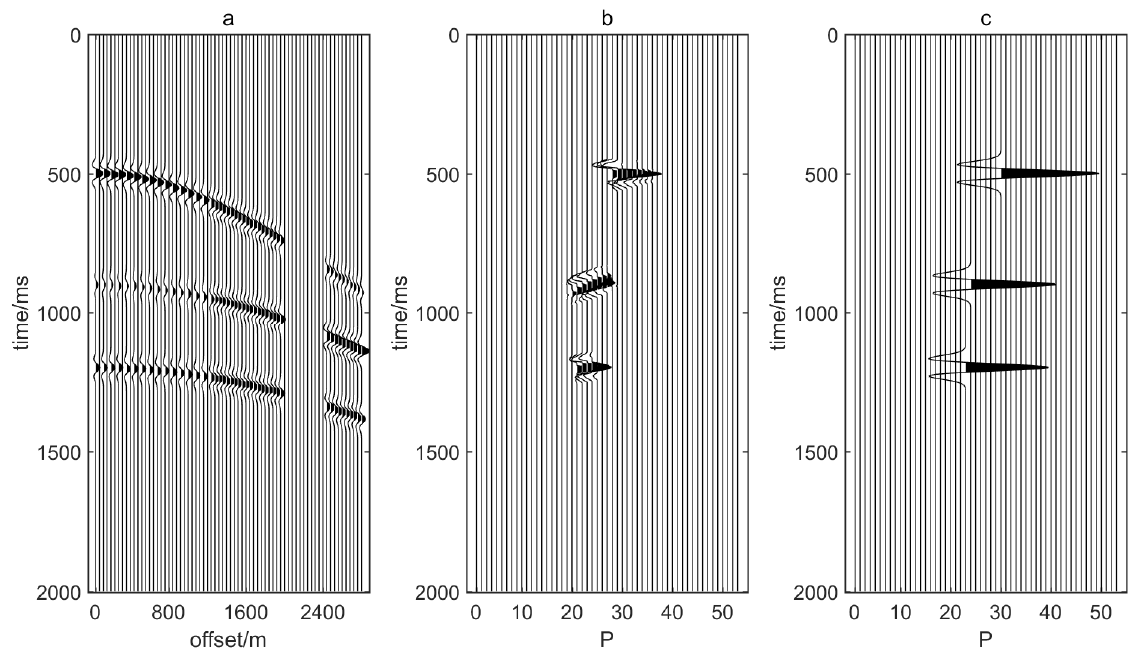
Figure 5. ( a ) Seismic data with voids; ( b ) Radon panel result of the CGRT; ( c ) Radon panel result of the WRT.